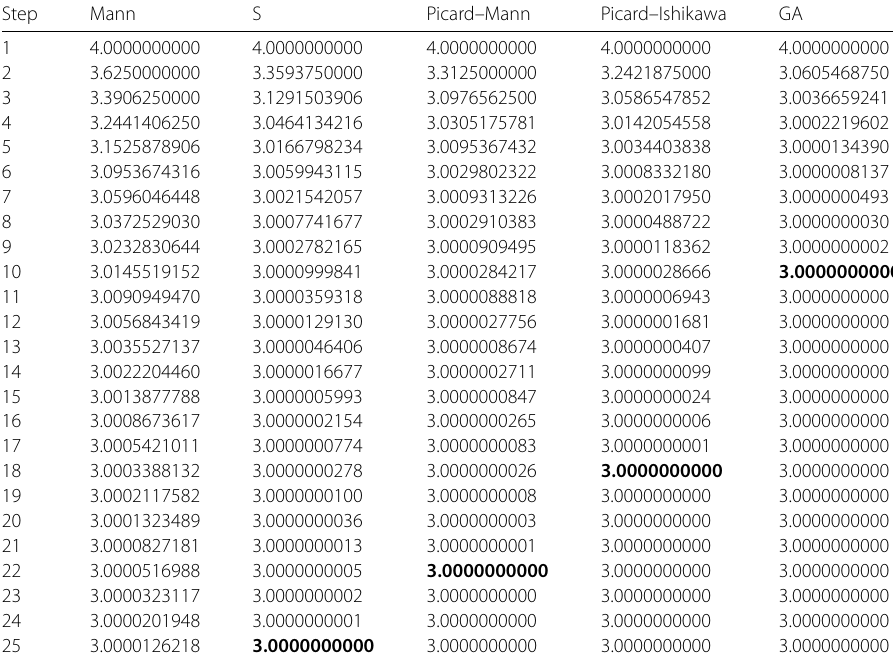
Table 1 Comparison of the GA iterative method with Mann, S, Picard–Mann and Picard–Ishikawa iterative methods